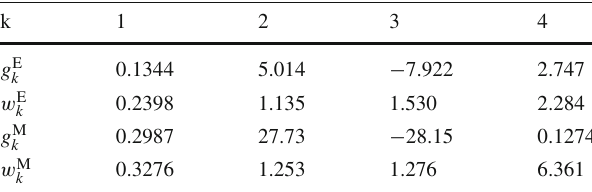
Table 2 New values of refitted parameters specifying electromagnetic proton form factors in Borkowski’s parameterization, see Eqs. (49) to (51). The parameters are expressed in units of GeV 2